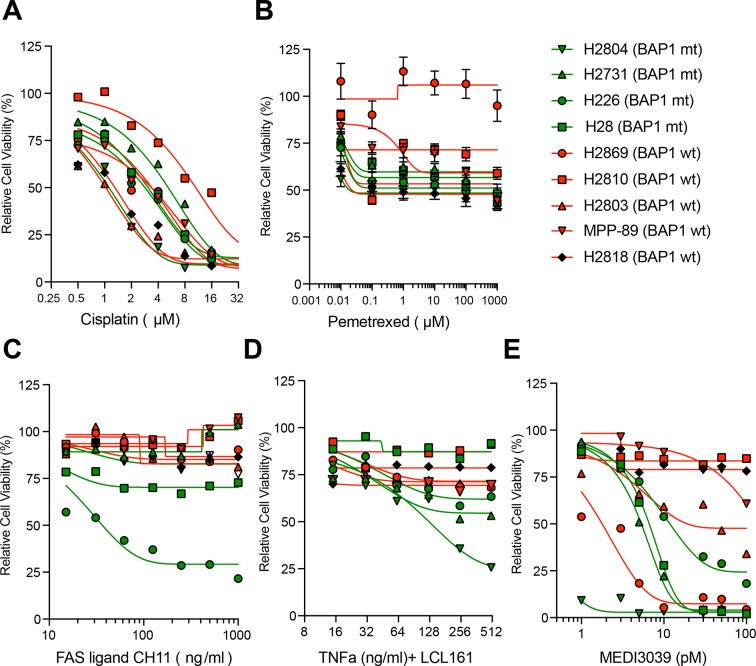
BAP1 and the response to alternative apoptotic stimuli in MM cells.72 hour cell viability results for 9 MM cell lines (4 BAP1-mutant - green and five wild-type - red) treated with (A) cisplatin (B) pemetrexed (C) FAS receptor agonistic antibody CH11, (D) TNF-α and 5 μM LCL161 or (E) DR5 agonist MEDI3039 assessed by MTT assay.